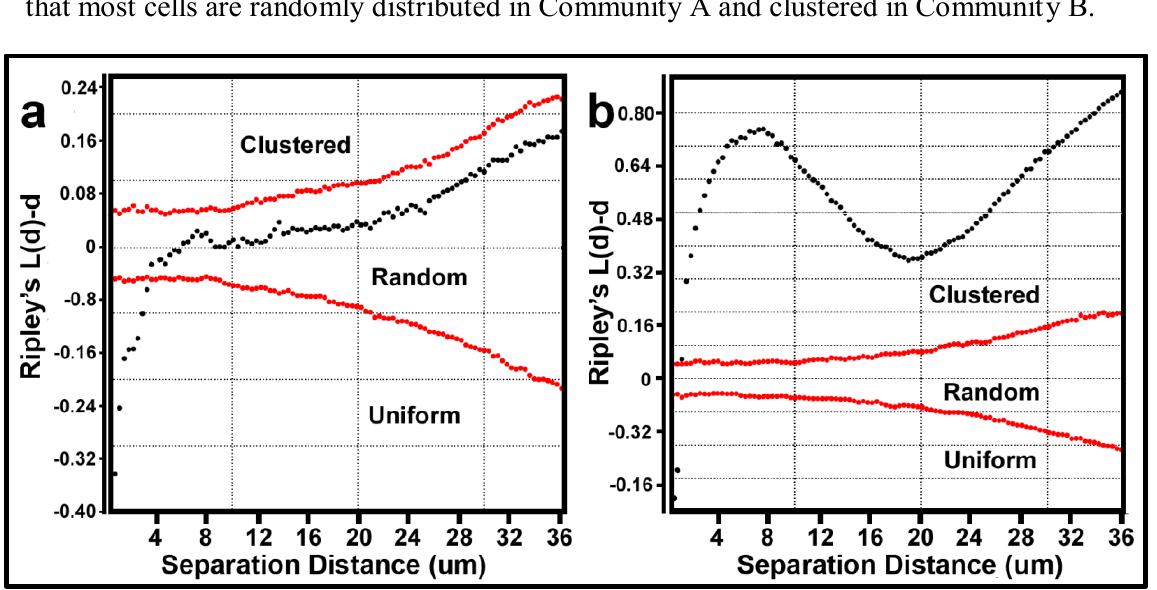
Figure 7. Donnelly edge-corrected and standardized Ripley K plots of point pattern characteristics for all bacteria within biofilm community assemblages of communities A and B developing on the ( a ) plain glass and ( b ) polystyrene substrata. The results indicate that most cells are randomly distributed in Community A and clustered in Community B.